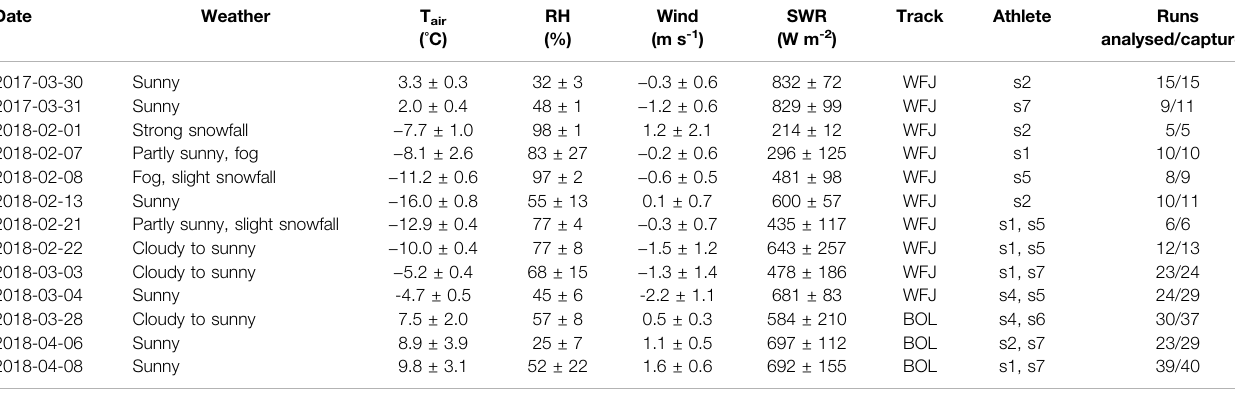
TABLE 2 | Weather description and average (mean ± σ ) weather parameters during the captured runs of each test day (date).